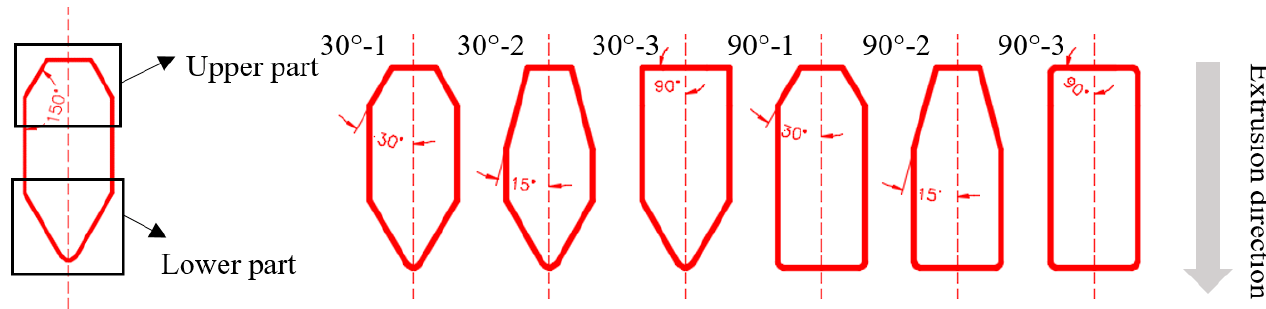
Figure 3. Schematics showing upper bridge geometries studied. Table 1. Summary of the bridge die geometries used in this research: (a) lower bridge and (b) upper bridge.